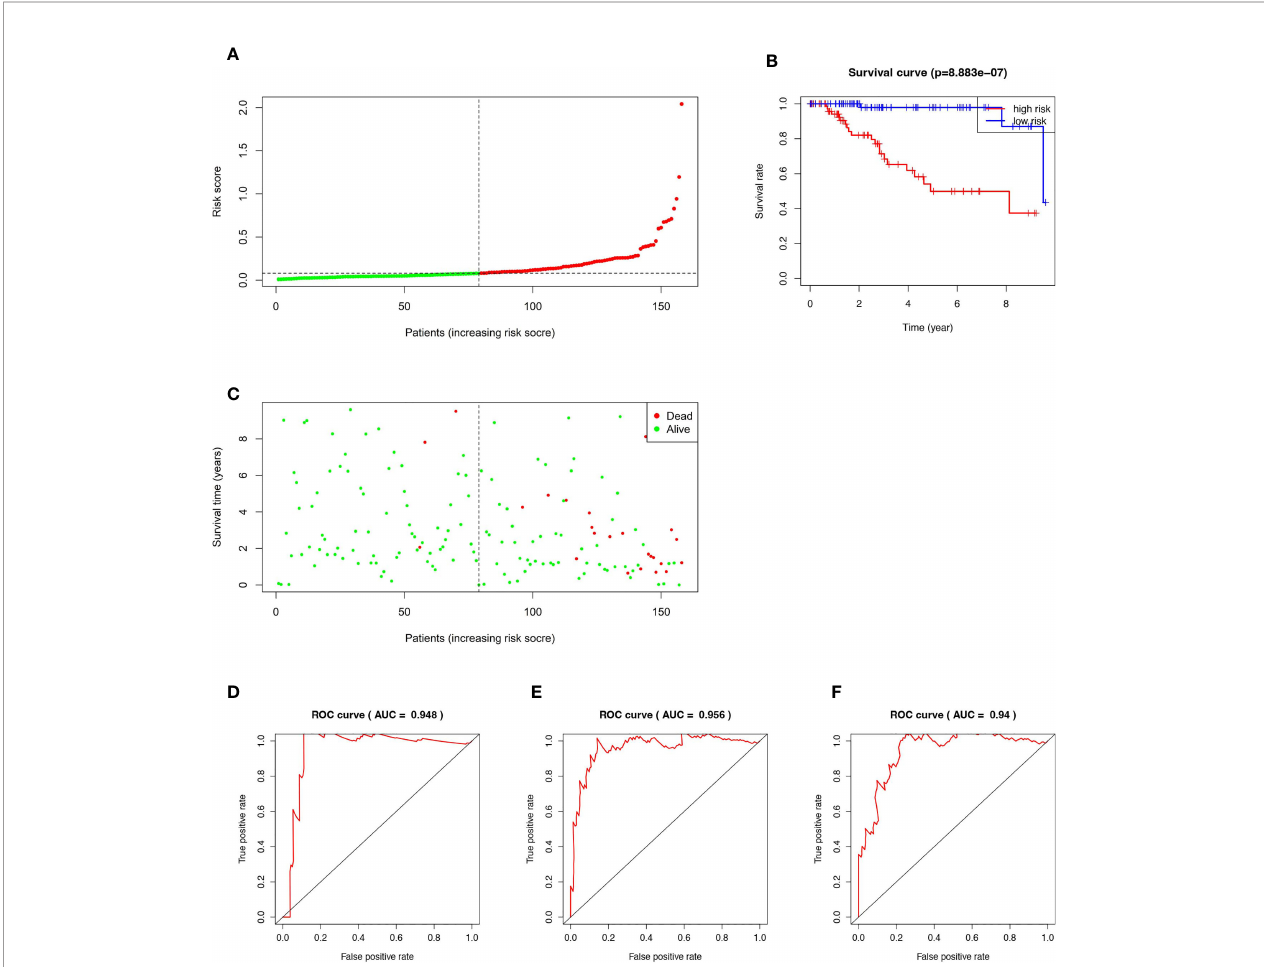
FIGURE 2 | Kaplan – Meier curve, Time-dependent ROC curve, Risk score analysis and Survival status analysis of the 15-ferroptosis-related gene signature. (A) Risk score analysis for the 15-ferroptosis-related gene signature. (B) Kaplan – Meier curve of 15-ferroptosis-related gene signature in the TCGA cohort. (C) Survival status analysis for the 15-ferroptosis-related gene signature. (D – F) The time-dependent ROC curve of 1-, 3-, 5-year OS of the 15-ferroptosis-related gene signature in the TCGA